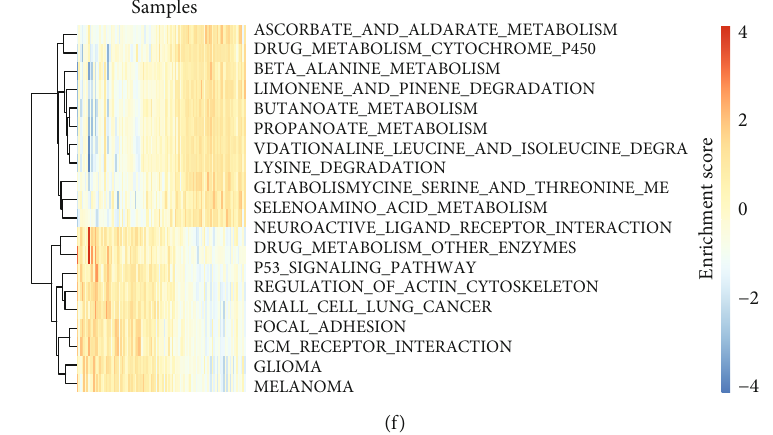
Figure 8: Three lncRNAs associated with prognosis in thyroid cancer were validated in GSE33630 dataset. (a – c) The expressions of FOXD2-AS1, FAM181A-AS1, and RNF157-AS1 between the tumor and normal in the GSE33630 dataset. (d – f) KEGG pathway analysis of FOXD2-AS1, FAM181A-AS1, and RNF157-AS1 in the GSE33630